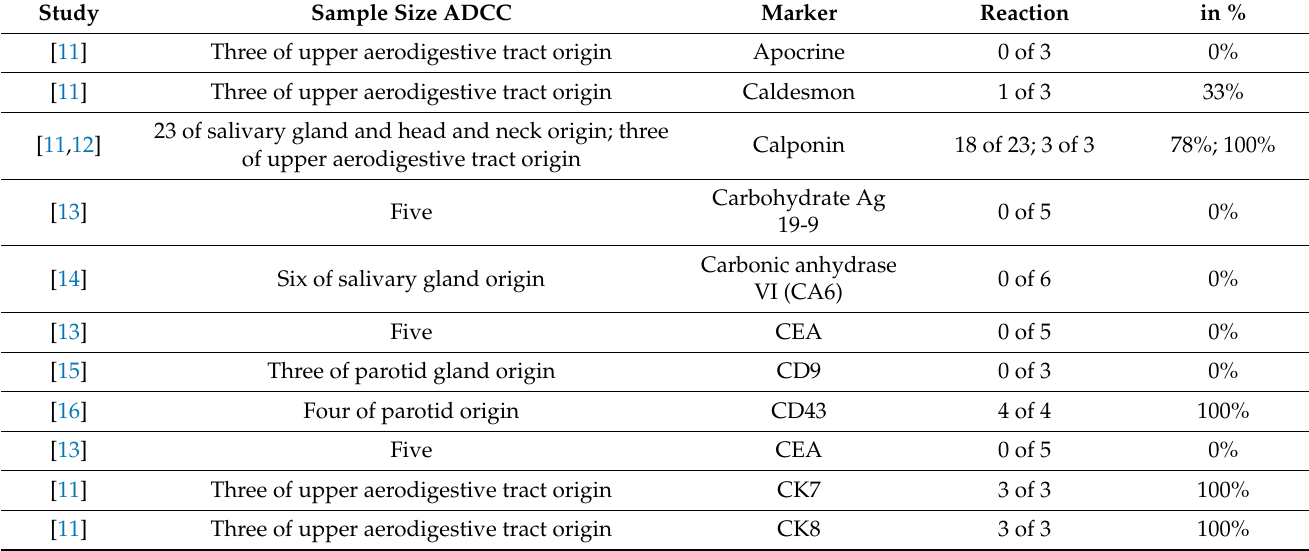
Table 2. Adenoid cell